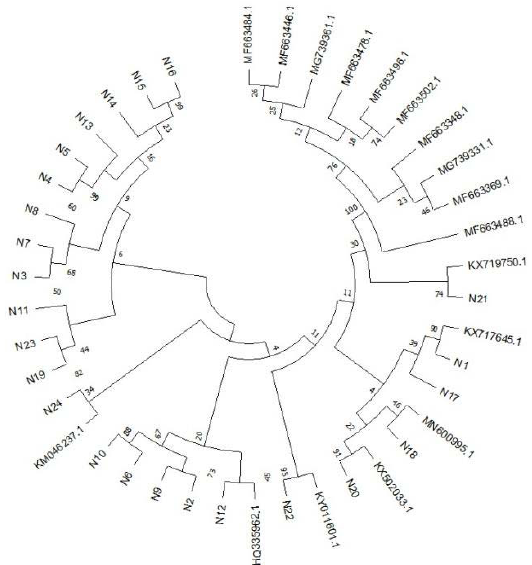
Figure 3. Phylogenetic tree was constructed based on nitrogen-fixing bacteria and their homologous strains.